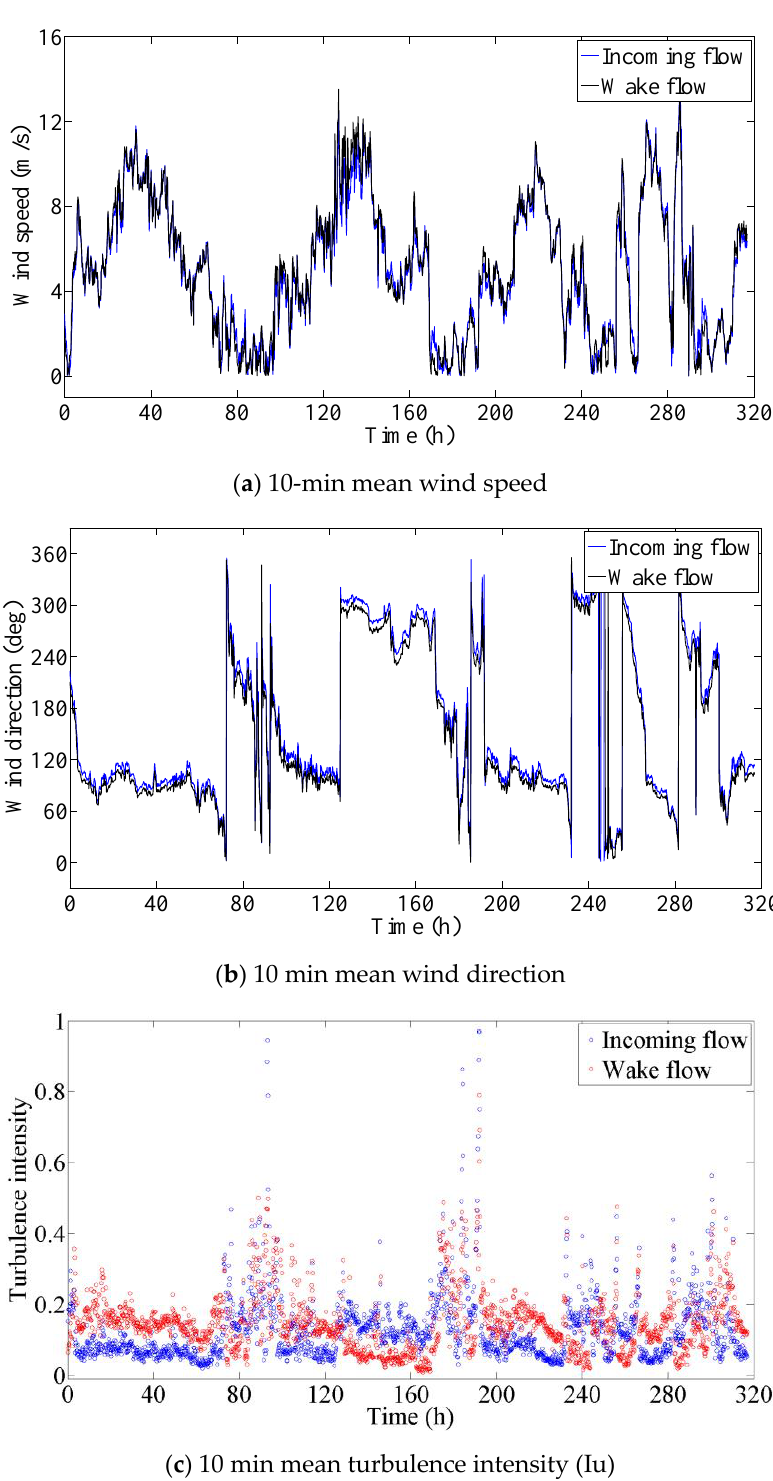
Figure 8. Ten-minute mean wind characteristics at the mid-span section of the investigated bridge in April (16 April 2010 to 29 April 2010).